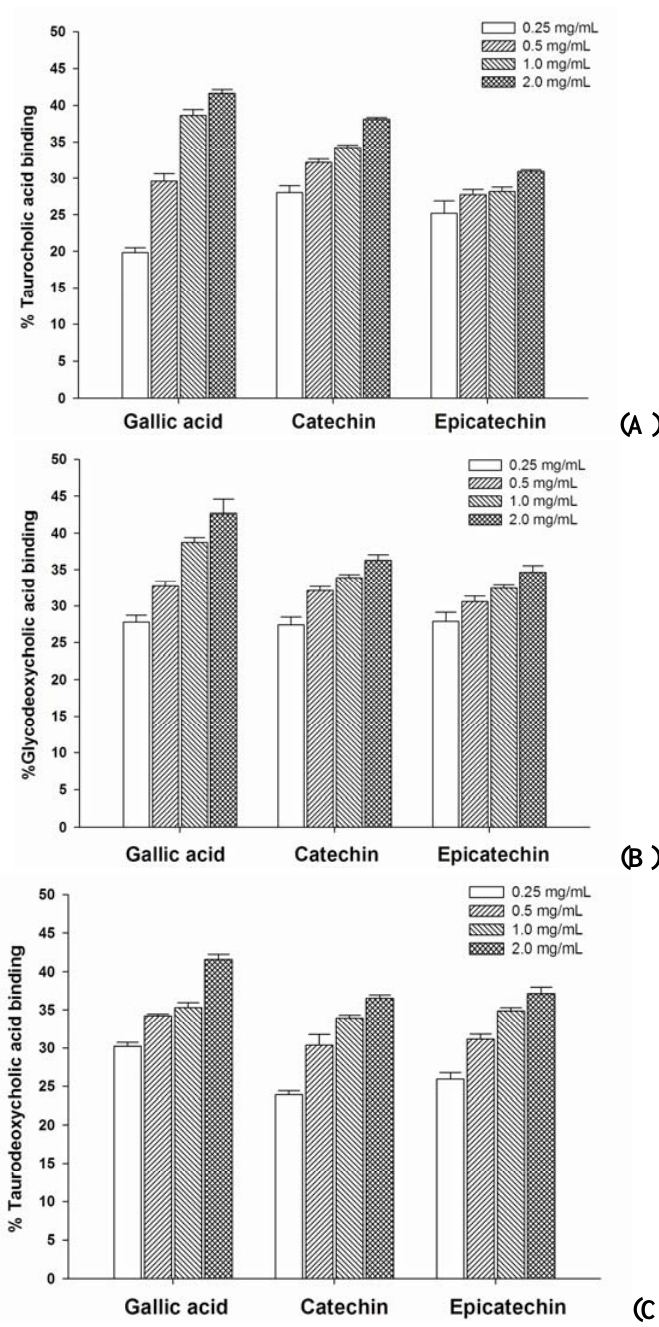
Figure 2. The percentage bile acid binding of gallic acid, catechin, and epicatechin. Results are expressed as mean ± S.E.M. , n =